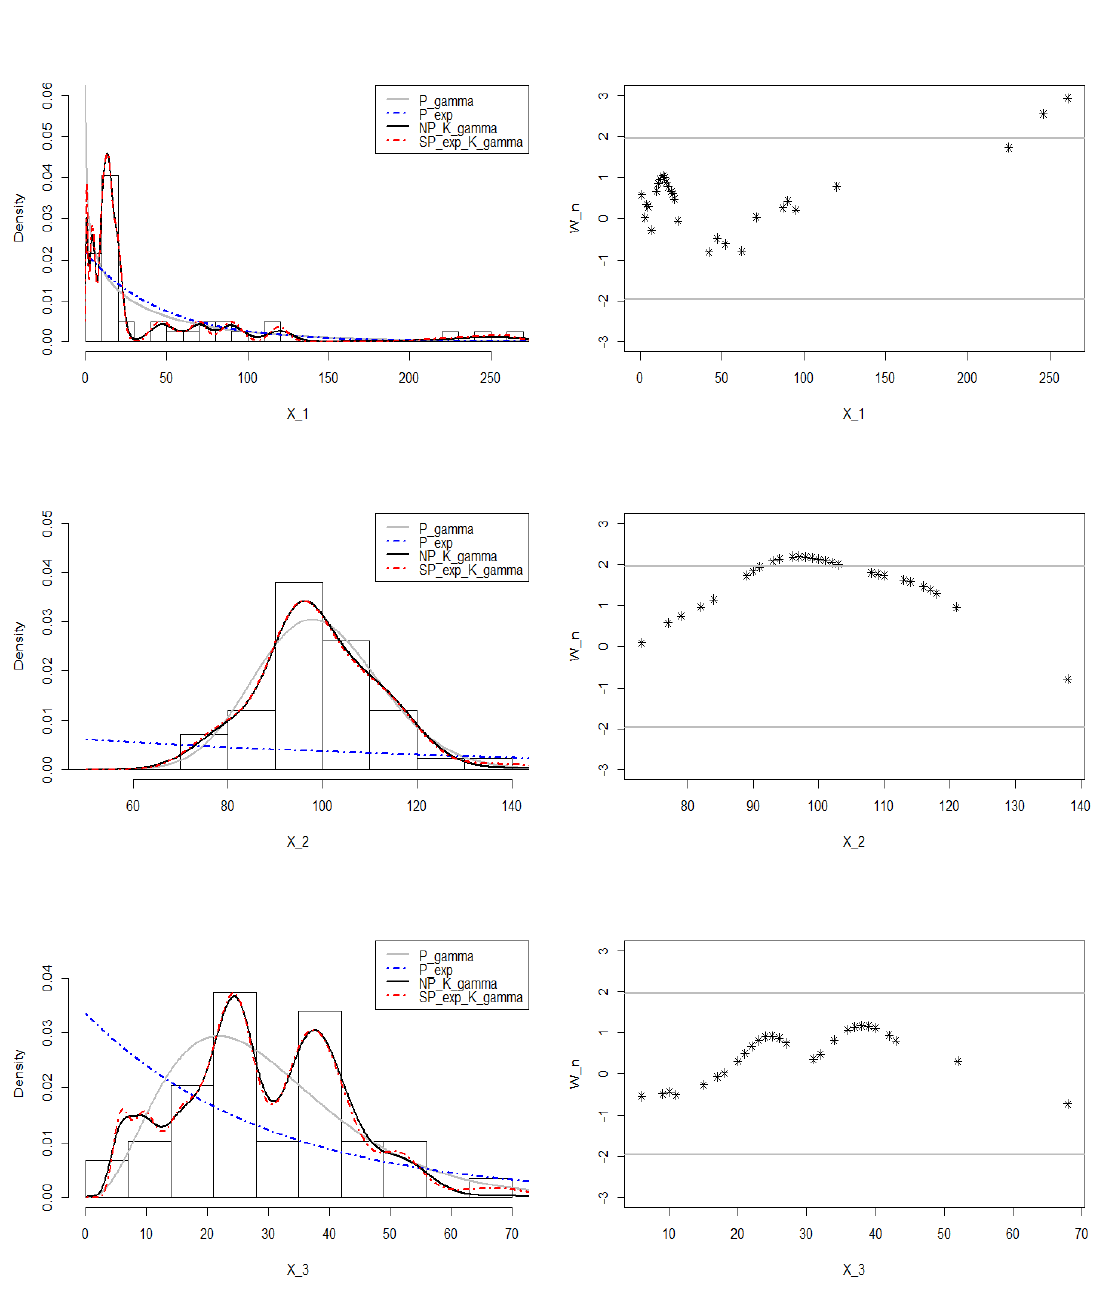
Figure 3. Comparative graphs of estimates of X 1 , X 2 and X 3 with their corresponding